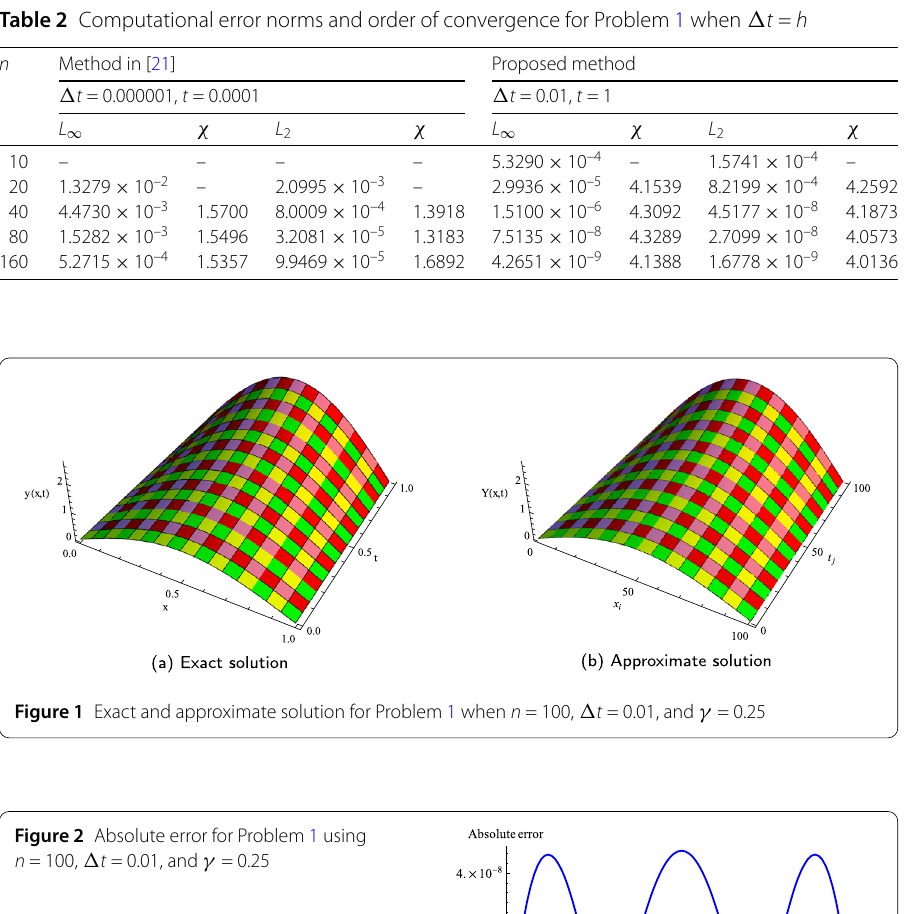
Figure 2 Absolute error for Problem 1 using n = 100, (cid:12) t = 0.01, and γ = 0.25